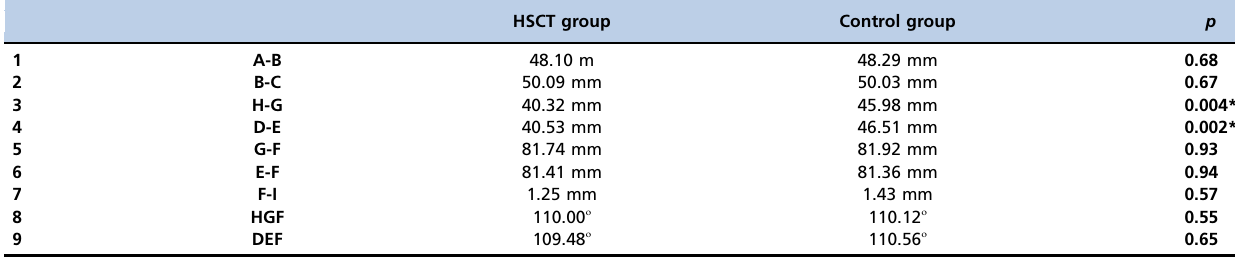
Table 3 - Cephalometric maxillomandibular assessment.